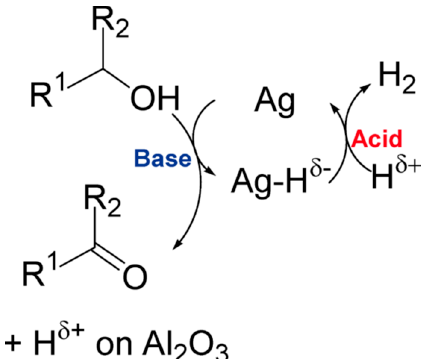
Figure 2. Proposed mechanism for oxidant-free dehydrogenation of alcohol. Reprinted with permission from reference [53]. Copyright 2011 Japan Petroleum Institute.